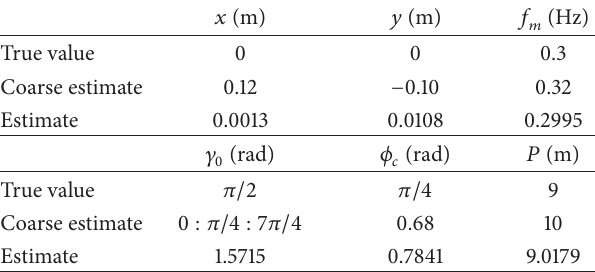
Figure 11: PRA’s image under SNR = −3 dB, by CBP. Table 2: Final estimated results.